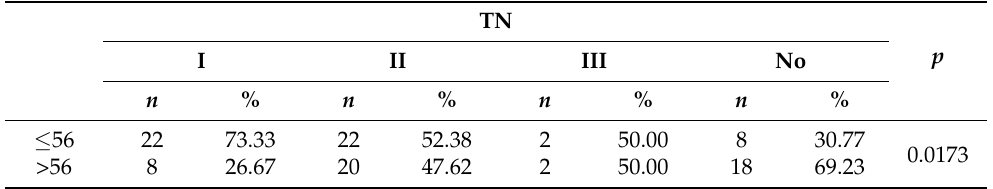
Table 8. The categories of treatment needs and the age of